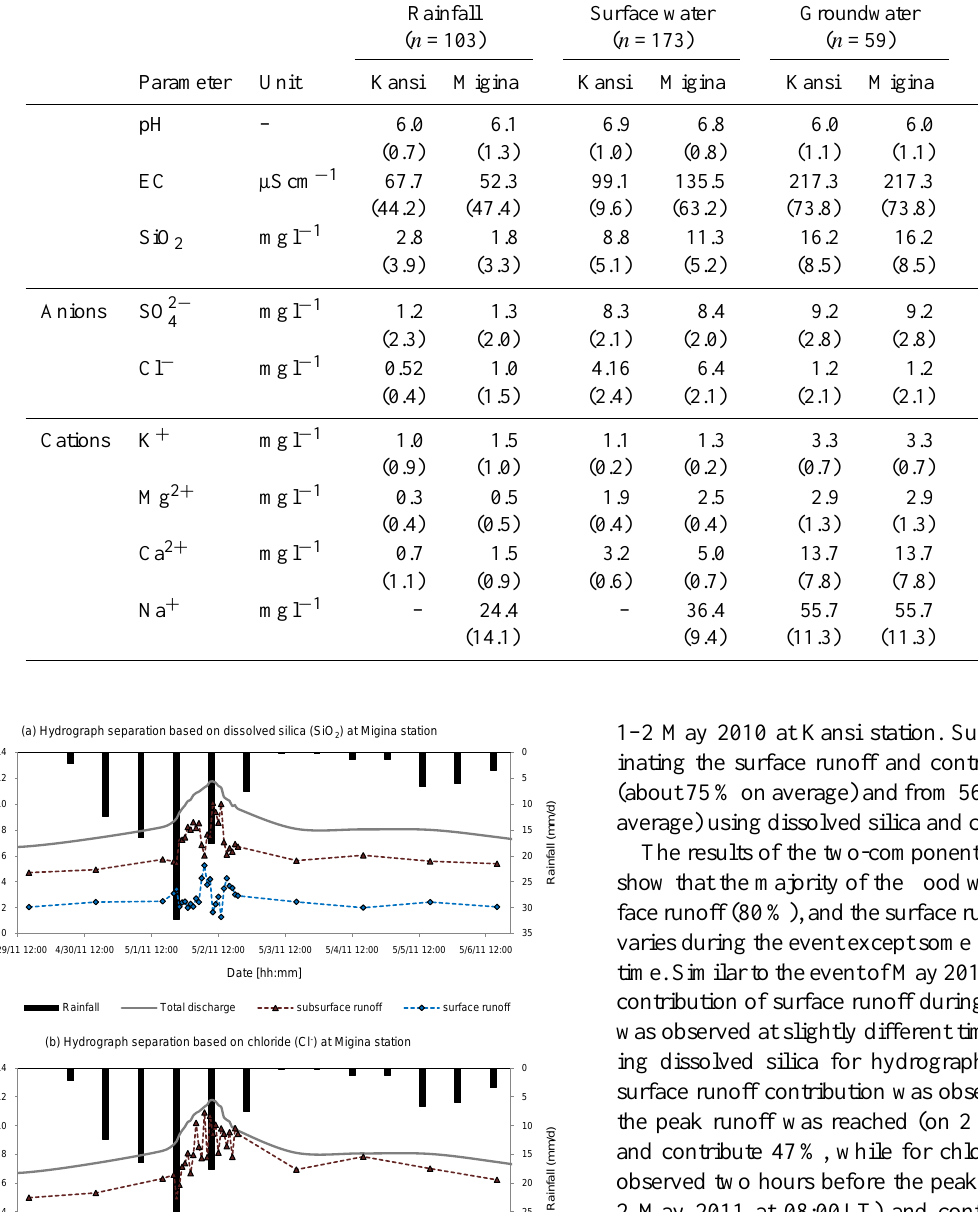
Table 3. Hydrochemical concentrations observed in the Kansi sub-catchment and Migina catchment during the investigated research period (from 1 May 2009 to 31 June 2011). n represents the number of samples. The entries in brackets represent the standard deviation values. Rainfall